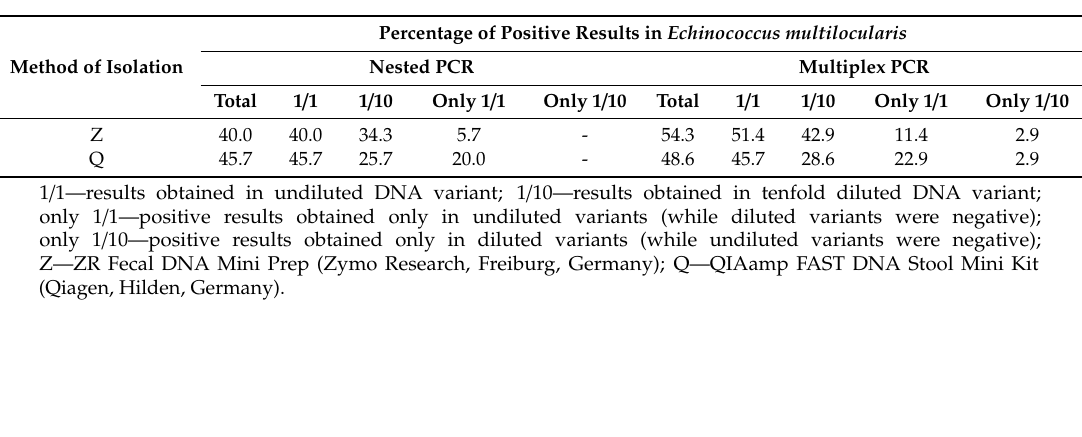
Table 1. Percentages of PCR Echinococcus multilocularis positive results among fecal samples obtaining from Echinococcus multilocularis sedimentation and counting technique (SCT) positive intestines.